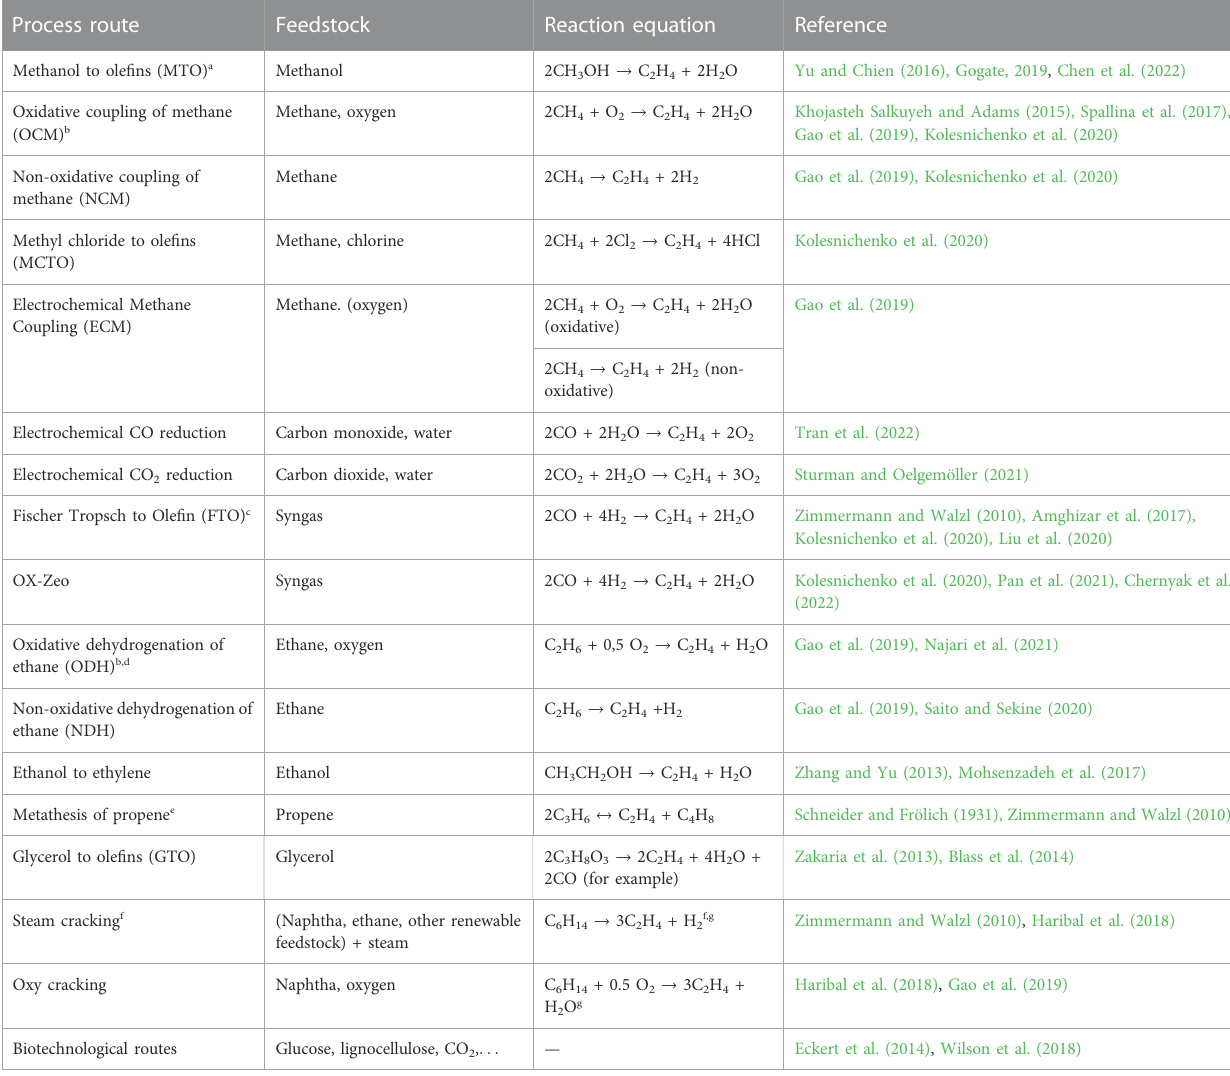
TABLE1Processesfortheproductionofethylenefromvariousfeedstock(Onlythemainreactionstowardsethyleneareshown,someprocessesproduceamixture of lower ole fi